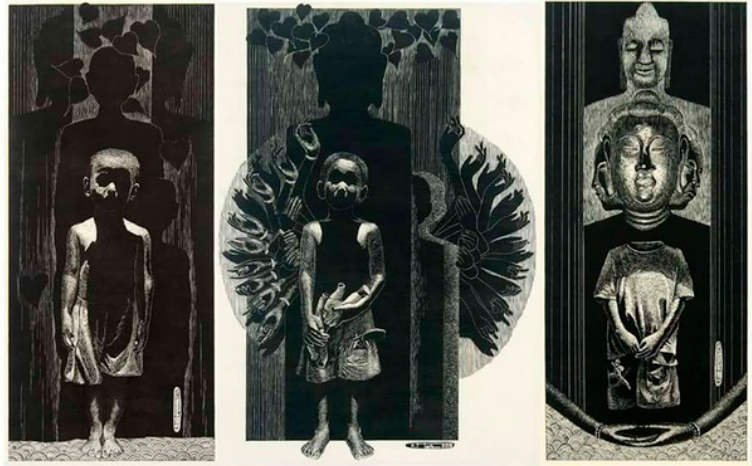
Figure 3. A di da Phat —Nguyen Khac Han painted in 2015. The image was sourced from Tuoi Tre Newspaper (Diep 2017a).